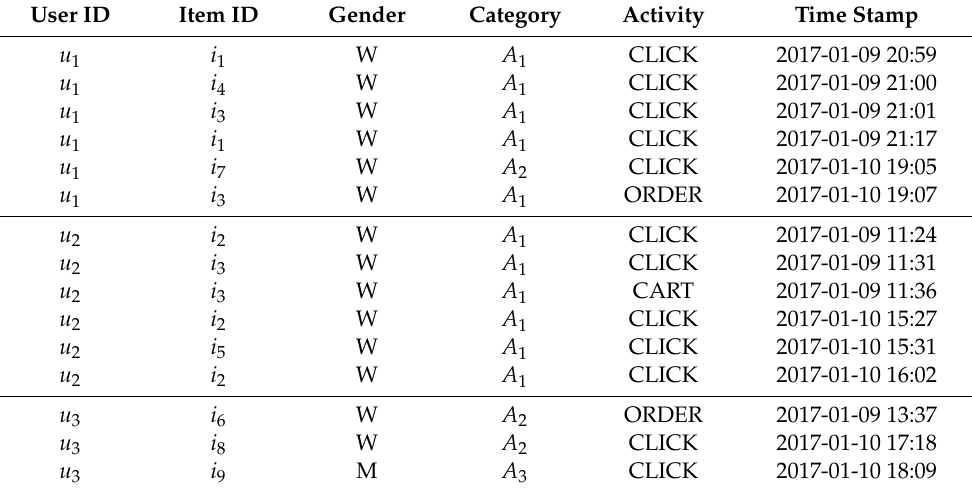
Table 1. An example of user activity